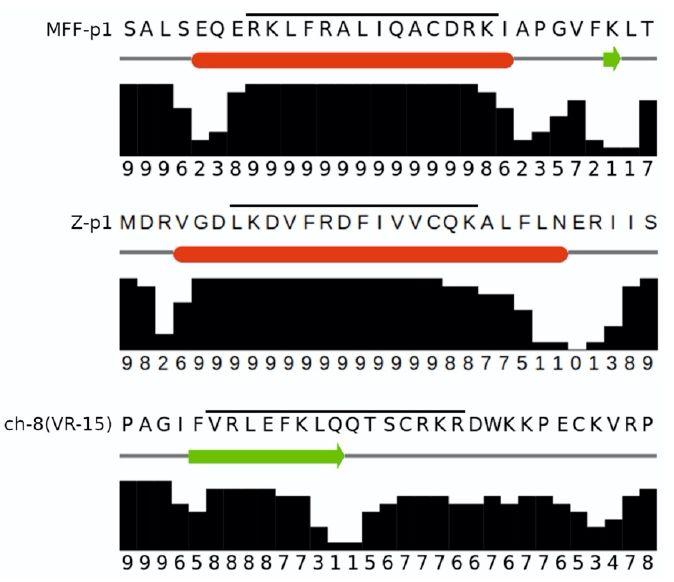
Figure 3. The JPRED4 secondary structure predictions for the MFF-p1 ( top ), Z-p1 ( middle ), and chemerin-8 (VR-15) ( bottom ) peptides. The fragment corresponding to the actual peptides is marked with a horizontal line. Predictions of an α -helix (red bars) and extended ( β -strand, the green arrow) conformation are accompanied by JPRED4 confidence scores.